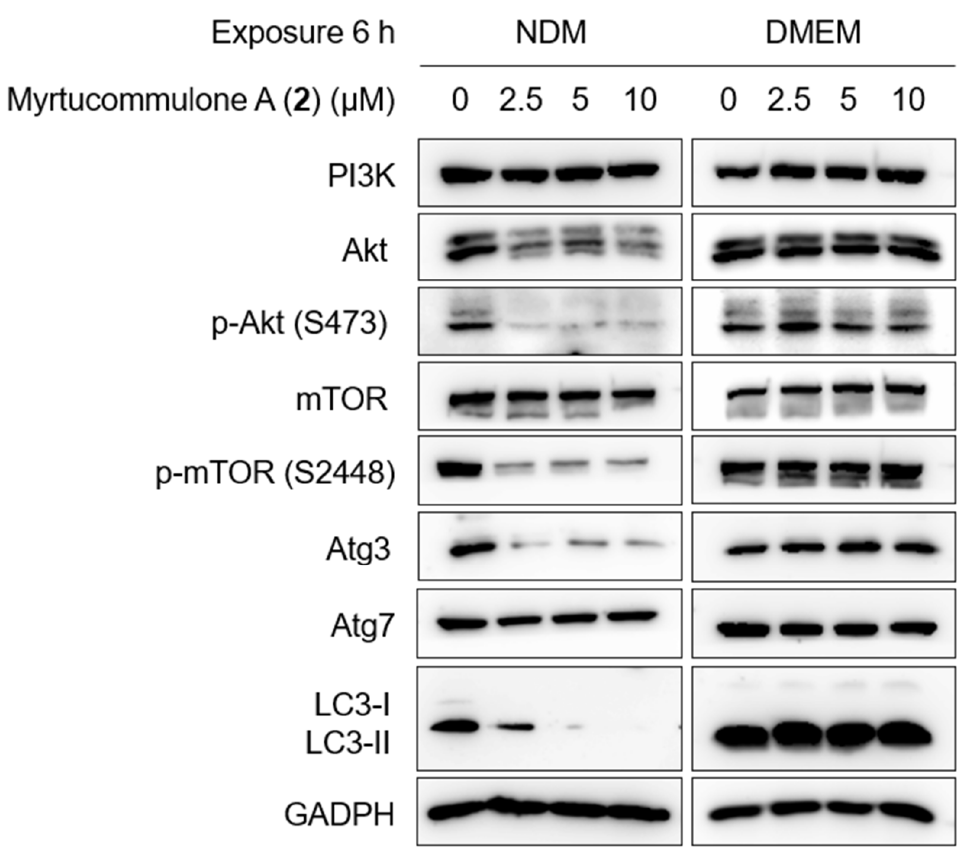
Figure 7. Effect of myrtucommulone A ( 2 ) on protein related to the PI3K/Akt/mTOR and autophagy signaling pathway under NDM and DMEM.